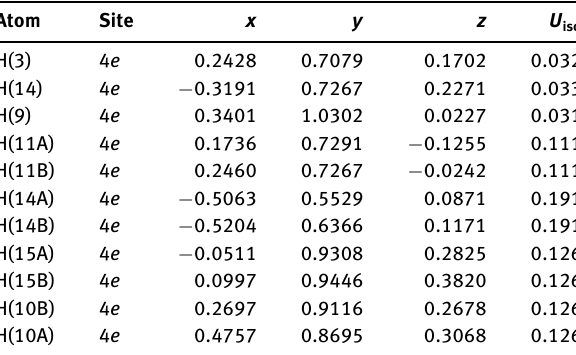
Table 2: Fractional atomic coordinates and isotropic or equivalent isotropic displacement parameters (Å 2